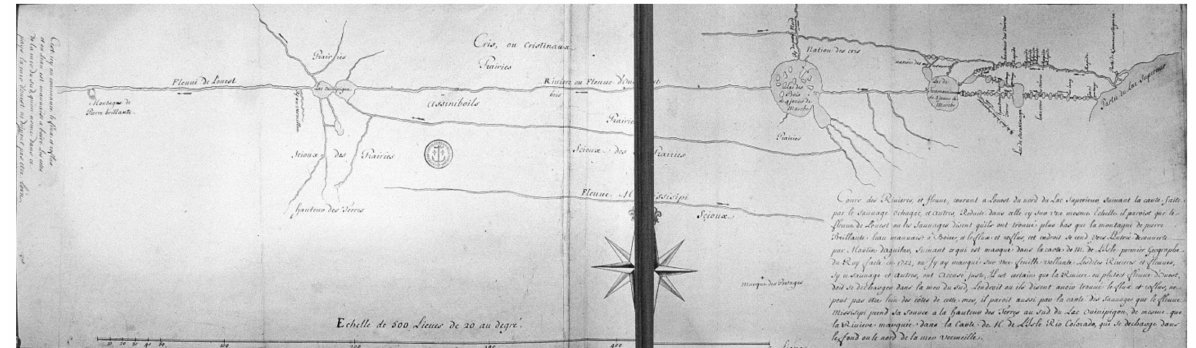
Figure 1. Map by Ochagach (Cree), traced by Philipp Bauche, of a water-bound route between Lake Superior and the unknown distant west. Downloaded and cropped from the Research Laboratories of Archaeology at the University of North